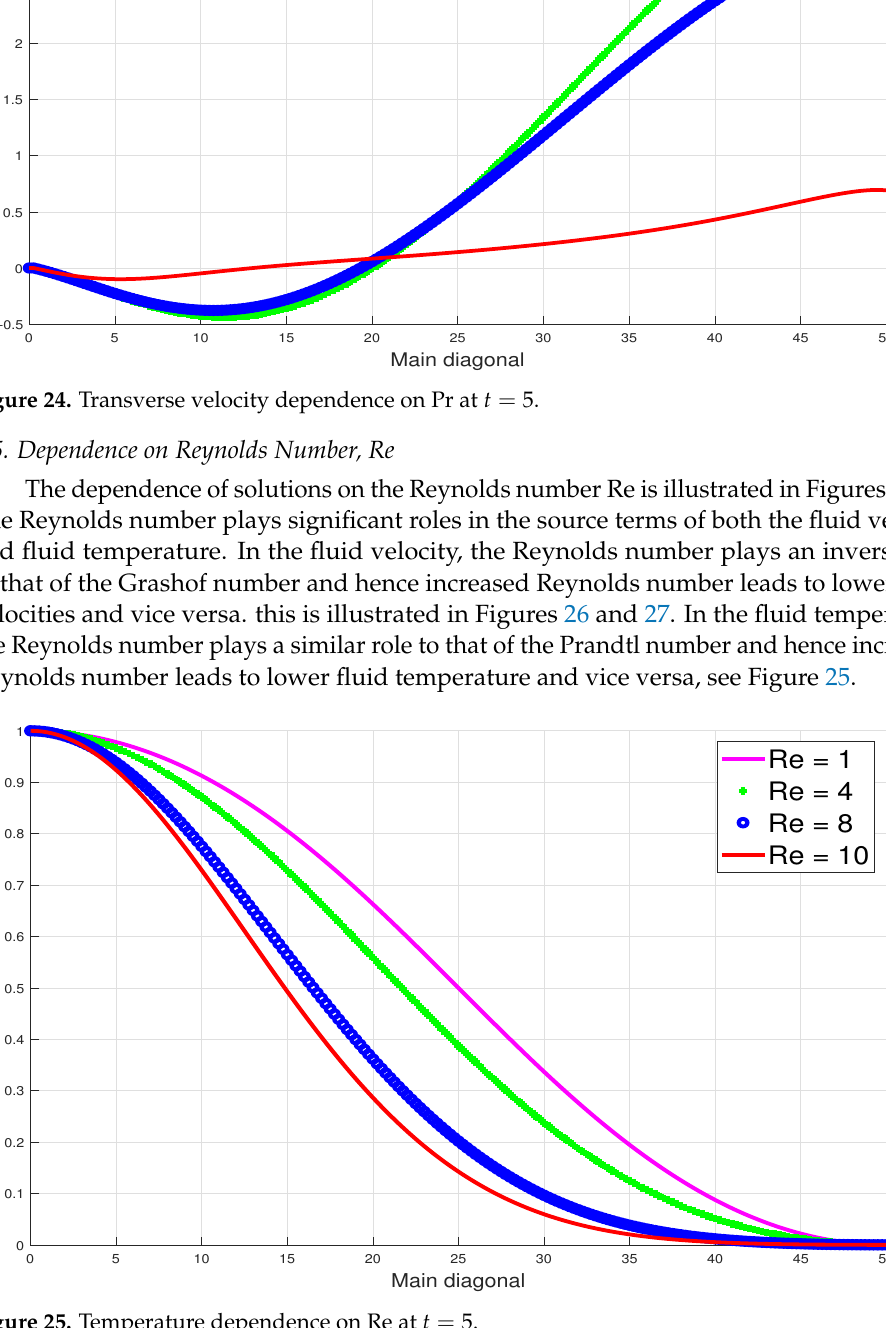
Figure 25. Temperature dependence on Re at t =